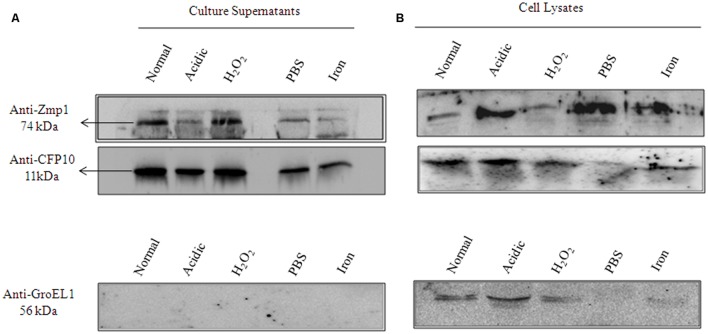
Zmp1 is expressed and secreted by in vitro grown Mycobacterium tuberculosis H37Rv under granuloma-like conditions.
(A) The culture supernatants of in vitro grown M. tuberculosis H37Rv under normal conditions and under various stress conditions, such as, acidic pH5.5, H2O2 induced oxidative stress, nutrient starvation and iron depletion, were precipitated by 10% trichloroacetic acid and the resultant precipitate was subjected to Western blot using Mouse anti-Zmp1 antibody (1:1000 dilution; Upper panel). Rabbit anti-CFP10 antibody (1:1000 dilution) against CFP10, a culture filtrate protein 10, was used as a positive control (Middle Panel) and Mouse anti-GroEL1 antibody (1:1000 dilution) against GroEL1, a cytoplasmic chaperone was used as a negative control (Lower Panel) to evaluate for cell lysis products in supernatants. The absence of band corresponding to GroEL1 in the supernatant fractions suggests the purity of culture filtrate preparations. (B) Figure represents the Western blots with the whole bacterial lysates as control experiment.